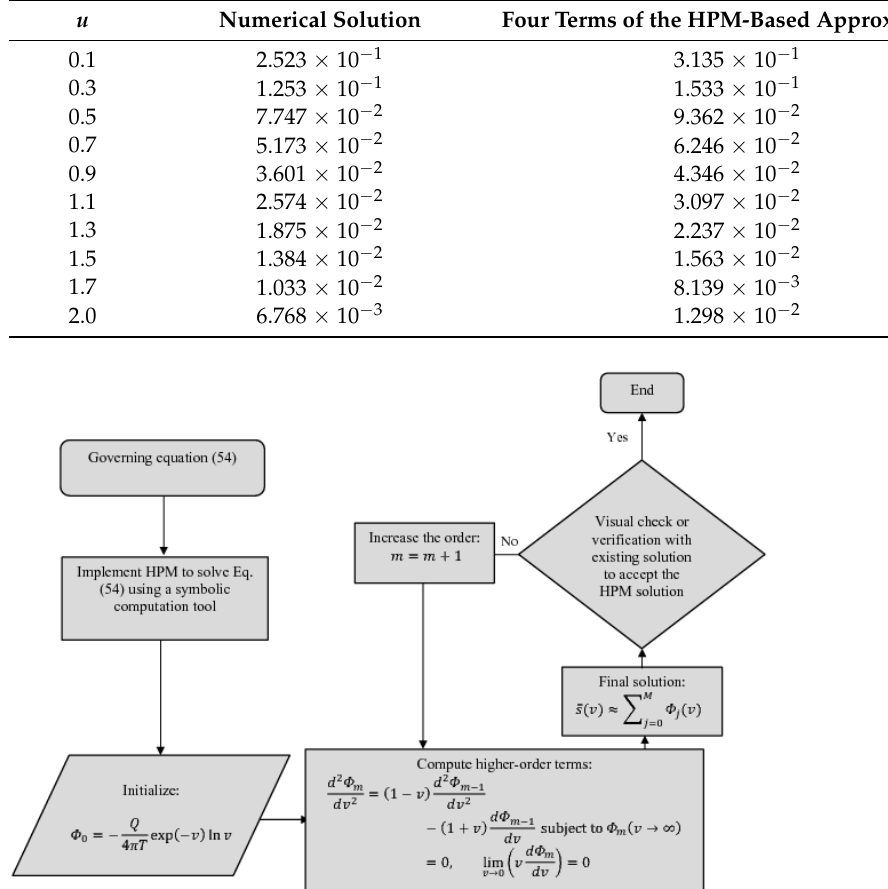
Figure 8. Comparison between the Theis solution and the four terms of HPM-based solution for the selected case. Table 3. Comparison between four terms of the HPM-based approximation and Theis solution for the selected case.